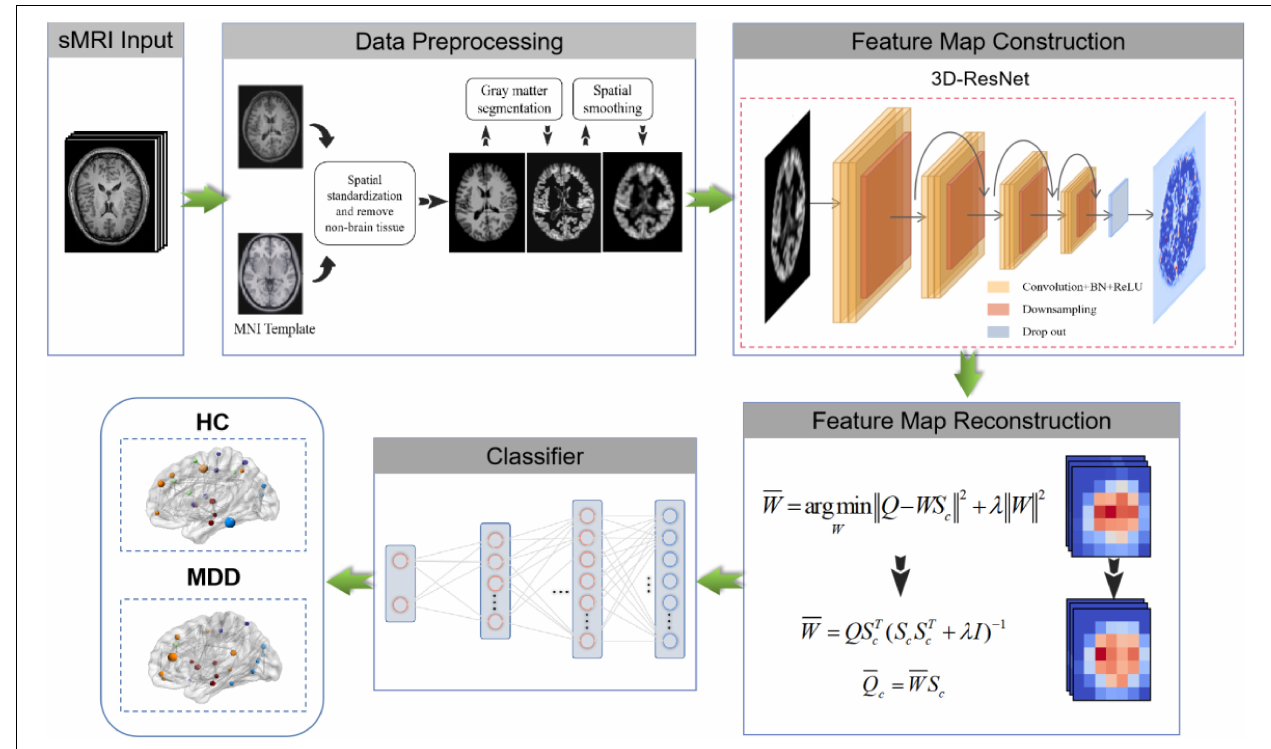
FIGURE 1 | The overall diagram of our proposed 3D FRN-ResNet